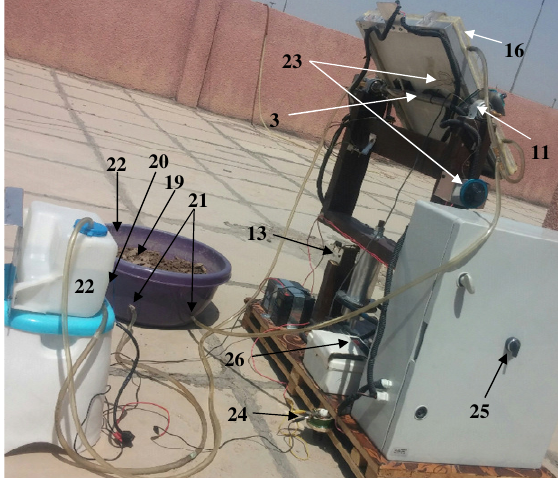
(b) back view Fig. 3. Experimental setup of the whole system:1- base, 2-cylindrical base, 3-central shaft, 4-PV panel, 5-driver pulley, 6- Motor M1, 7-driven pulley, 8-V- belt, 9-Motor M2, 10-frame, 11-pillow block bearing, 12: LDR sensors S1-S4, 13: Limit switches LS1-LS4, 14-DC battery, 15-control board, 16- WFDG chamber, 17-chamber inlets, 18-chamber outlet, 19-heat exchanger in mud basin, 20-water pump, 21-heat exchanger inlet/outlet, 22-water tank, 23-thermostst and its sensor, 24-Rheost, 25- main switch S-SW, 26-digital meter.